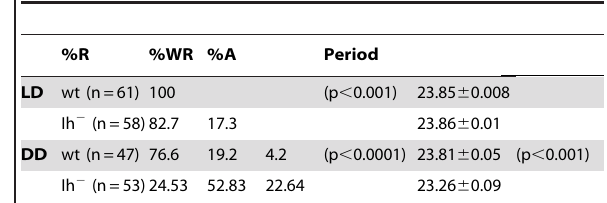
Table 1. Rhythmicity